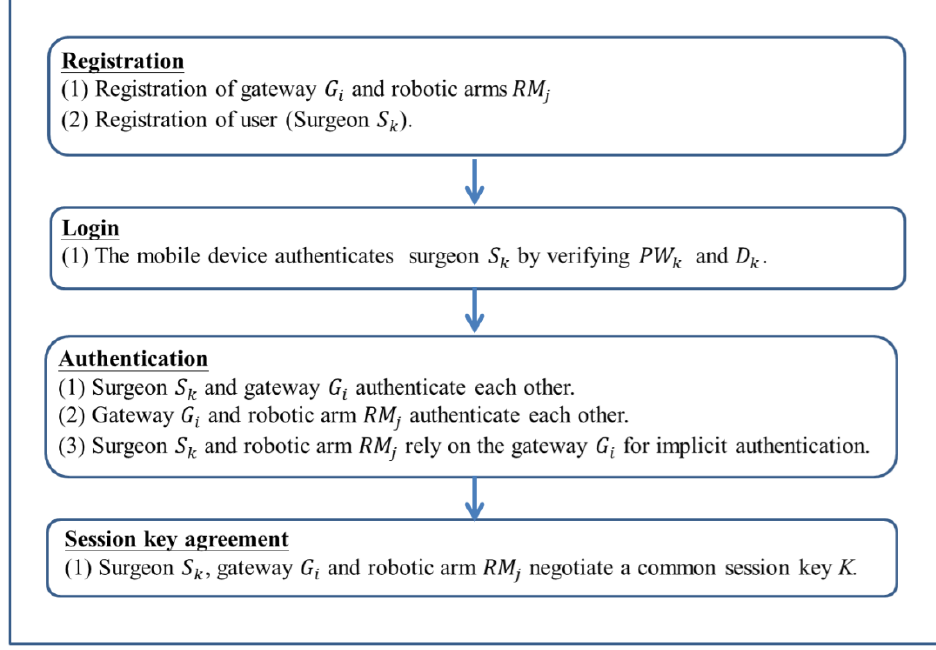
Figure 2. Flow chart of the enhanced scheme.